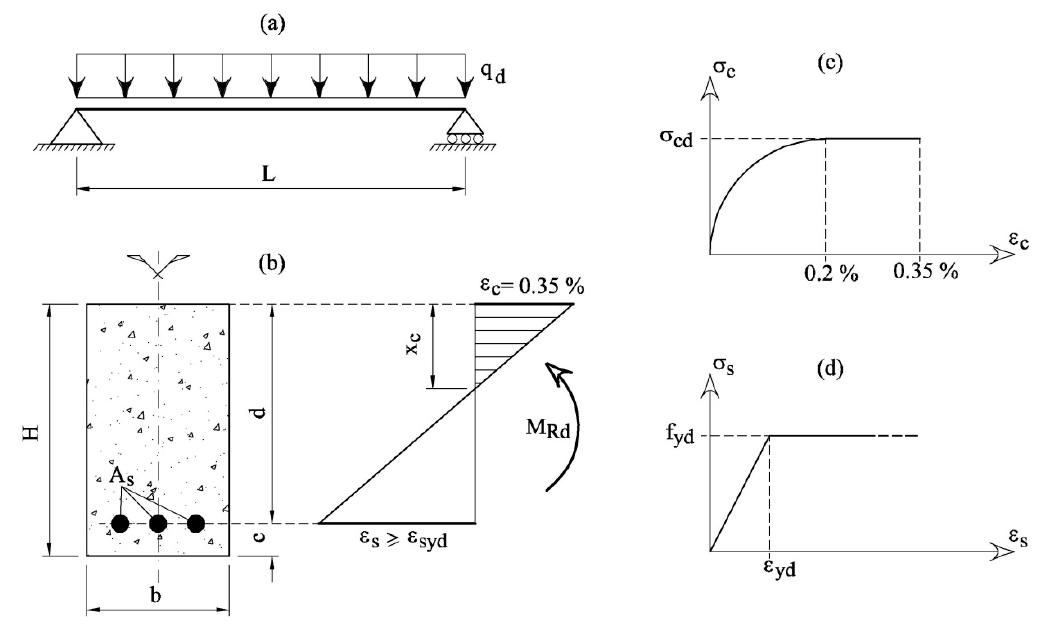
Figure 4. The ultimate limit state in reinforced concrete beams in bending: ( a ) a simply supported beam subjected to distributed loads; ( b ) the limit state profile in a cross-section; ( c ) the parabola–rectangle relationship for concrete; and ( d ) the elastic–perfectly plastic relationship for steel.